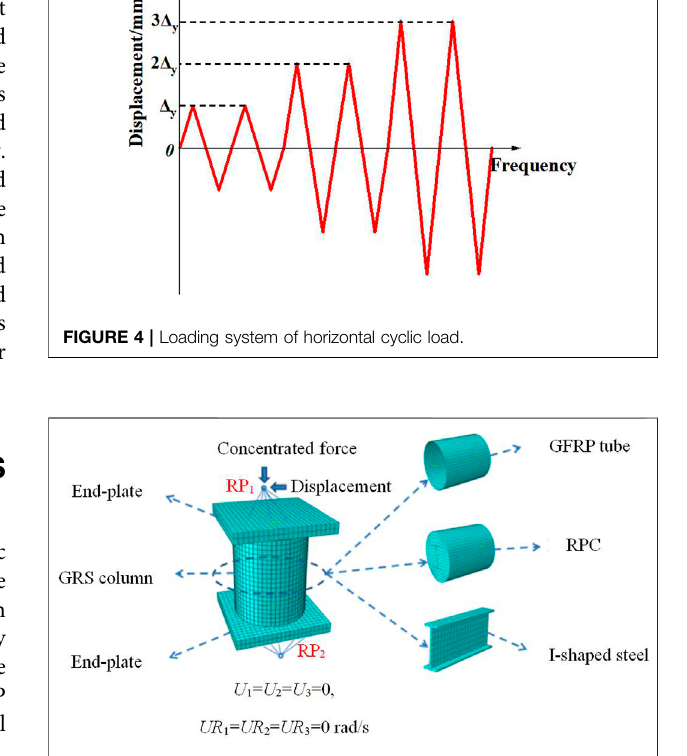
FIGURE 5 | Finite element models of GRS composite